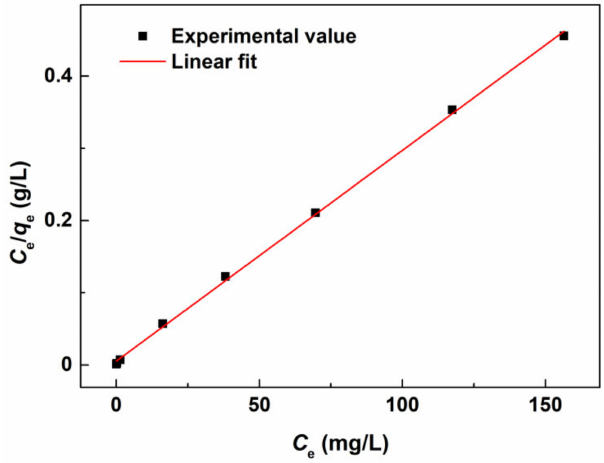
Figure 11. Langmuir linear fit of Cd 2 + adsorbed onto Fe 3 O 4 @SiO 2